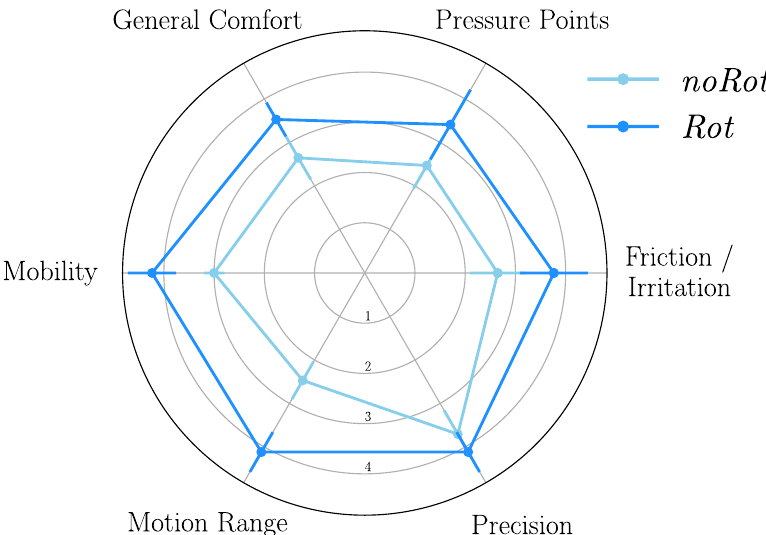
Figure 6. Average answers of the participants to the ergonomic feedback